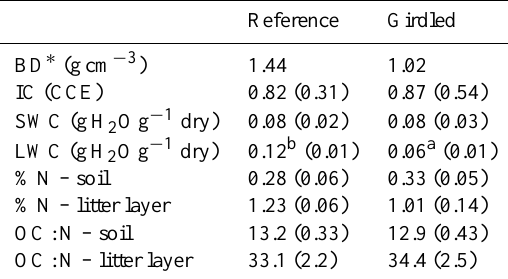
Table 2. Properties of soil samples collected underneath pi˜non canopies on 16 August 2010 from the 0cm to 10cm depth and litter layer samples collected just above the mineral soil sur- face at the same locations as the soil samples. BD=bulk density, IC=inorganic C, CCE=%CaCO 3 equivalent, SWC=soil water content, LWC=litter water content, OC:N=organic C to total ni- trogen ratio. Values in parentheses are the SE of the mean ( n = 5). Different superscript letters denote values that are significantly dif- ferent between the two sites ( α = 0 . 05). ∗ Bulk density measure- ments were conducted one year prior to study and represent the av- erage of two samples collected at 5cm depth.